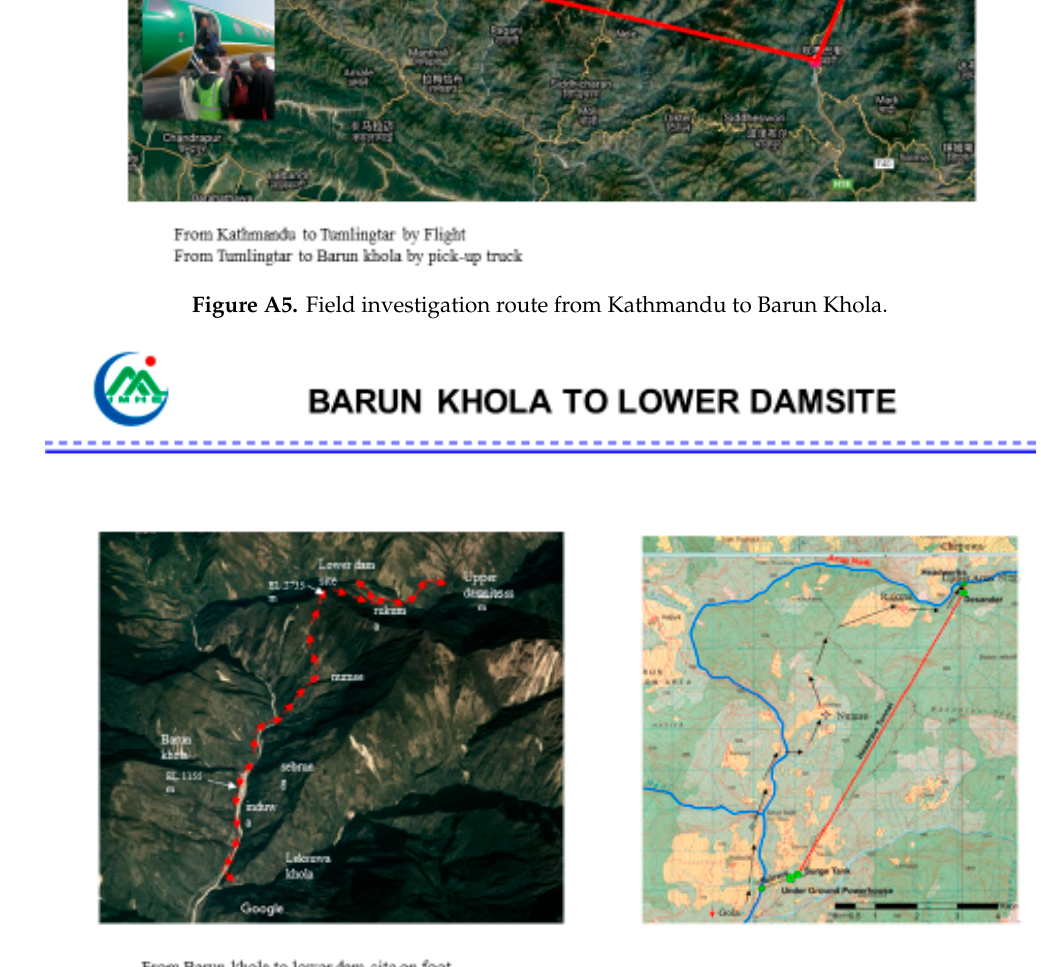
Figure A6. Field investigation route from Barun Khola to lower dam site .